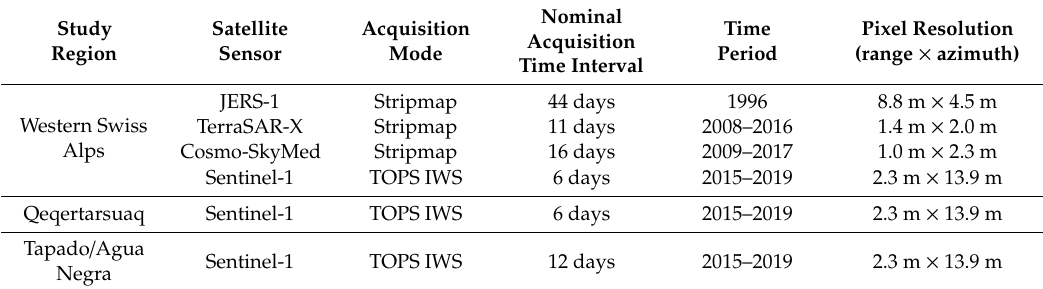
Table 1. Overview of sensors, acquisition modes, time periods, and pixel